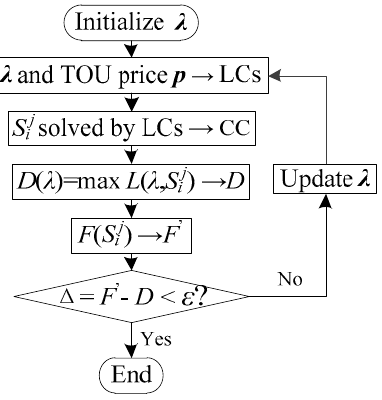
Figure 6. Flowchart of decentralized optimization of dispatching CS.